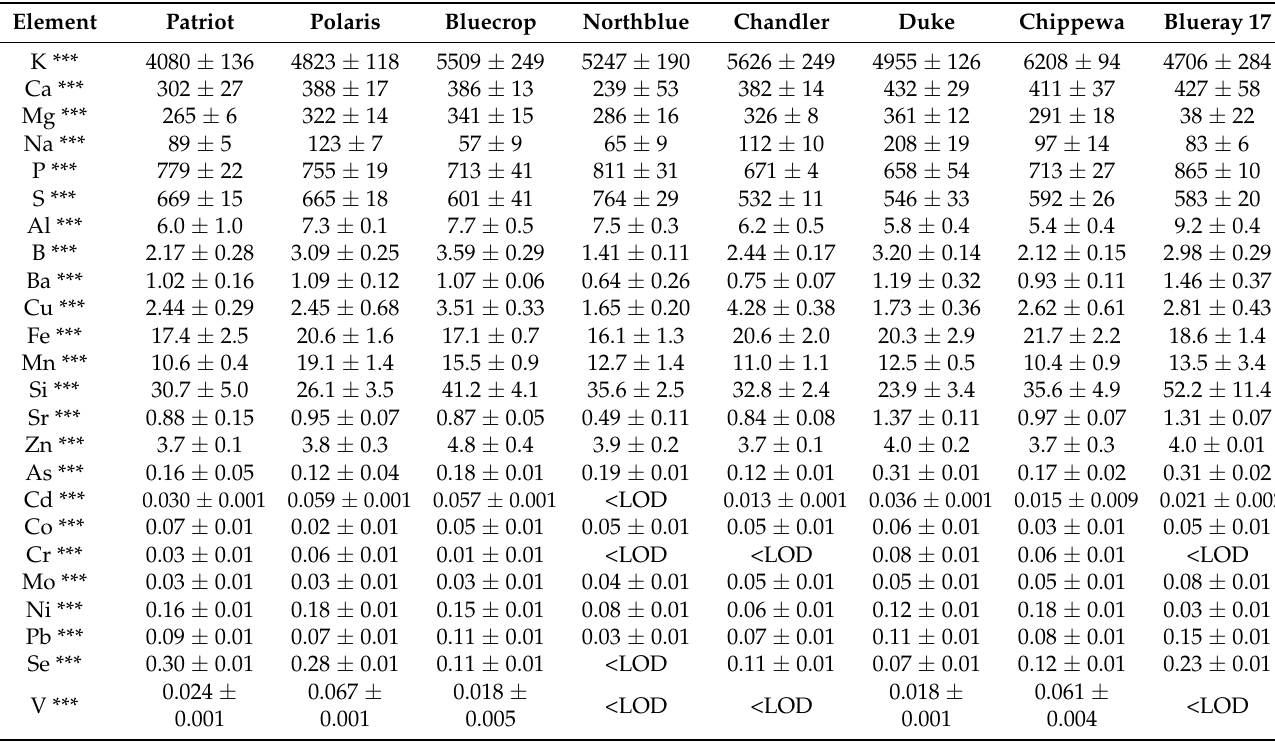
Table 1. Concentrations (mg/kg) of elements in blueberry cultivar samples from